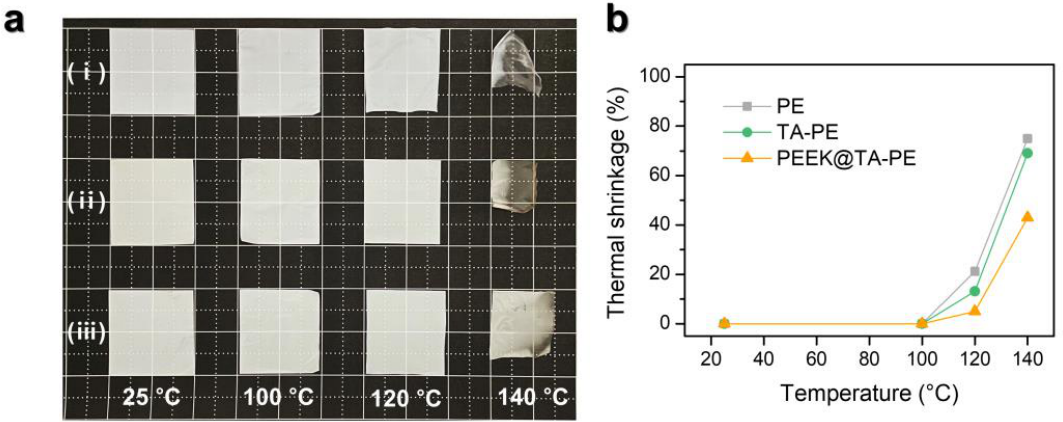
Figure 6. ( a ) Digital photographs of the ( i ) PE, ( ii ) TA-PE, and ( iii ) PEEK@TA-PE separators after heat treatment at each temperature; ( b ) thermal shrinkage calculation results.